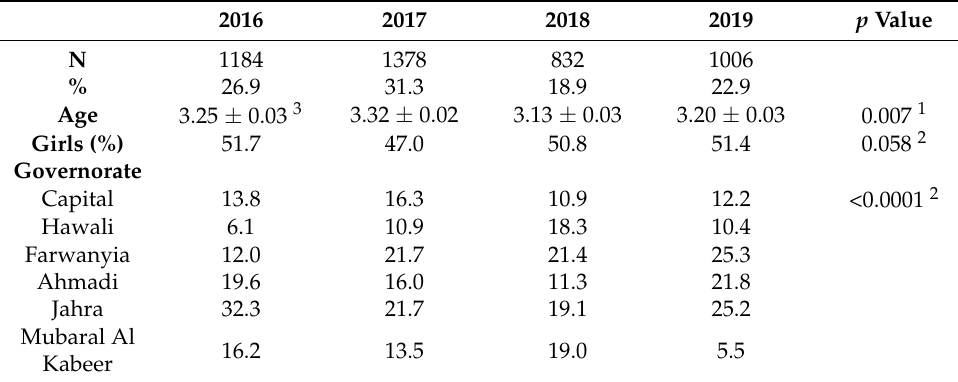
Table 1. Socio-demographic